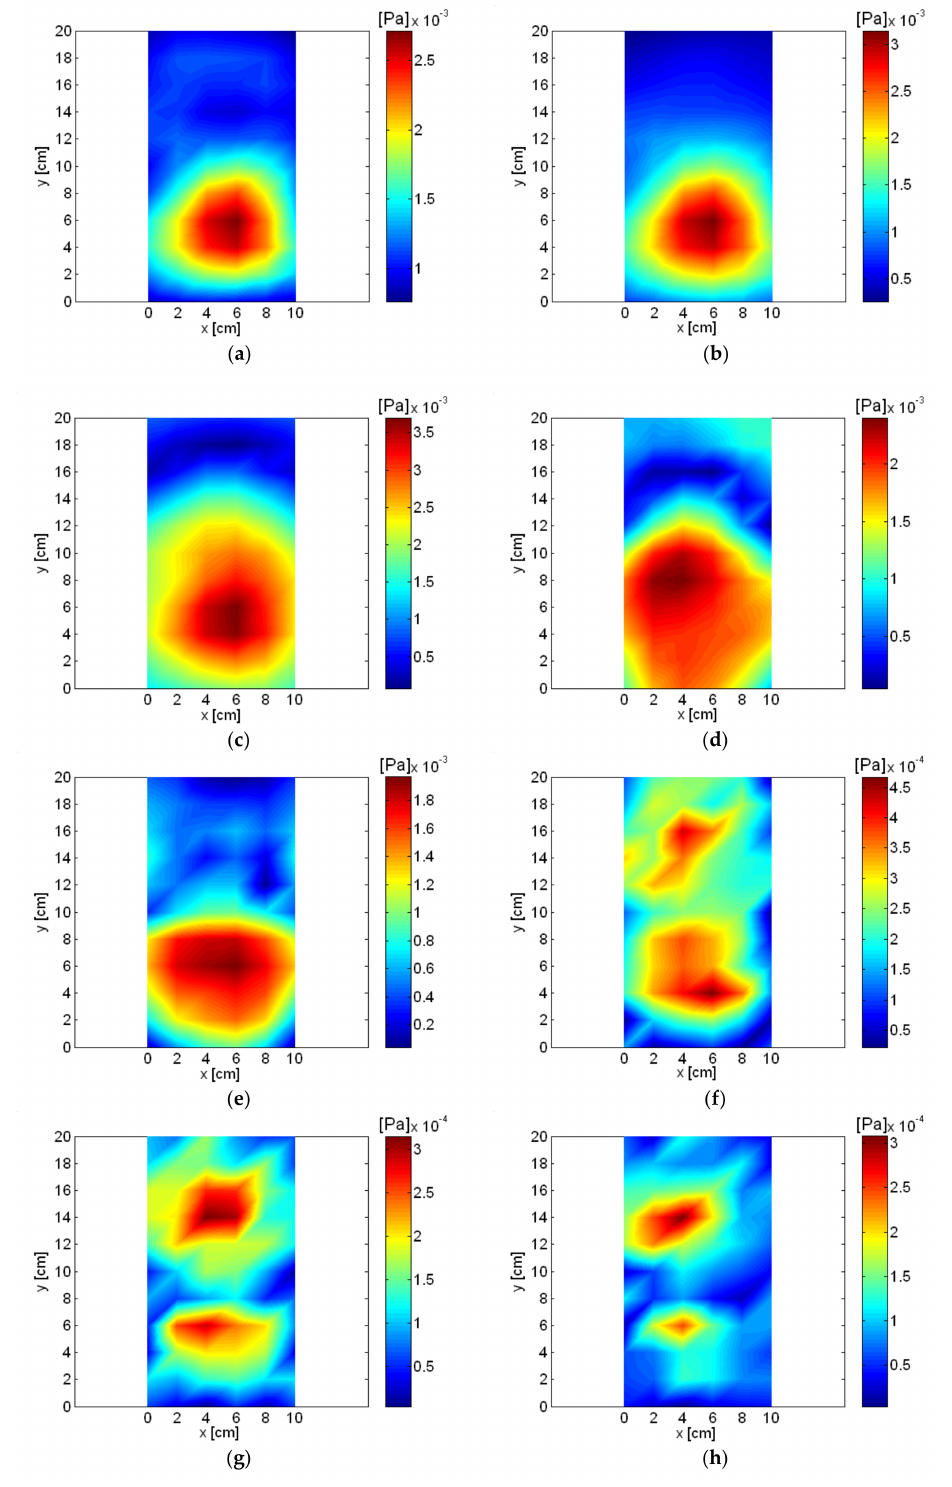
Figure 8. Reconstructed sound pressure of the loudspeaker: ( a ) 300 Hz; ( b ) 1000 Hz; ( c ) 1896 Hz; ( d ) 3000 Hz; ( e ) 4000 Hz; ( f ) 7000 Hz ( g ) 8000 Hz; ( h ) 8500